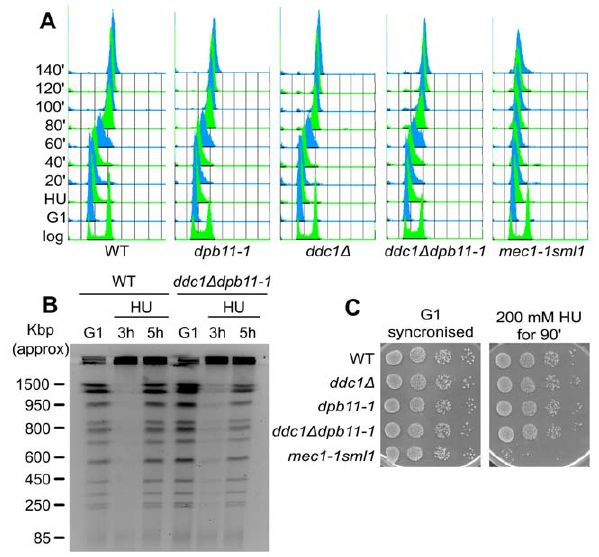
Figure 3. Low levels of Rad53 activity are sufficient to prevent replication fork breakdown. (A) HU recovery assay: K699 (WT), YFP20 ( dpb11-1 ), YAN21/8d ( ddc1 D ), YFP62/1d ( ddc1 D dpb11-1 ) and YMIC5A3 ( mec1-1 ) were synchronized in G1 with a -factor and released into fresh medium supplemented with 200 mM HU. 90 min later cells were transferred to fresh YPD + nocodazole and allowed to resume DNA replication. Progression into S phase was monitored by FACS analysis. (B) The indicated strains were synchronized in G1 with a -factor and released into 100 mM HU + nocodazole. 3 and 5 hours later cells were harvested and total DNA was analyzed by Pulse Field Gel Electrophoresis (PFGE). (C) The strains in panel A were synchronized in G1 and released in YPD supplemented with 200 mM HU. 90 min later 10-fold serial dilution were prepared and spotted onto YPD plates. The same was done with the G1-synchronised cultures as